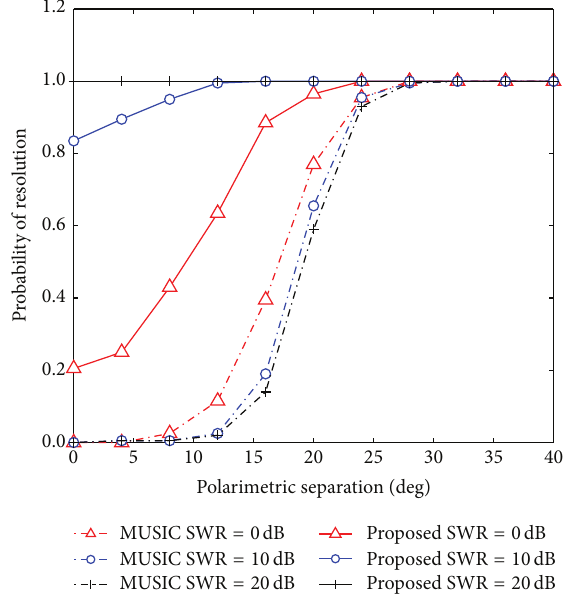
Figure 6: Resolution probability against the polarimetric separa- tion, where the strong source is located at (𝜃 1 ,𝛾 1 ) = (3 ∘ , 30 ∘ ) and the weak source is located at (𝜃 2 ,𝛾 2 ) = (6 ∘ , 𝛾 1 + Δ) with SNR = 5 dB.